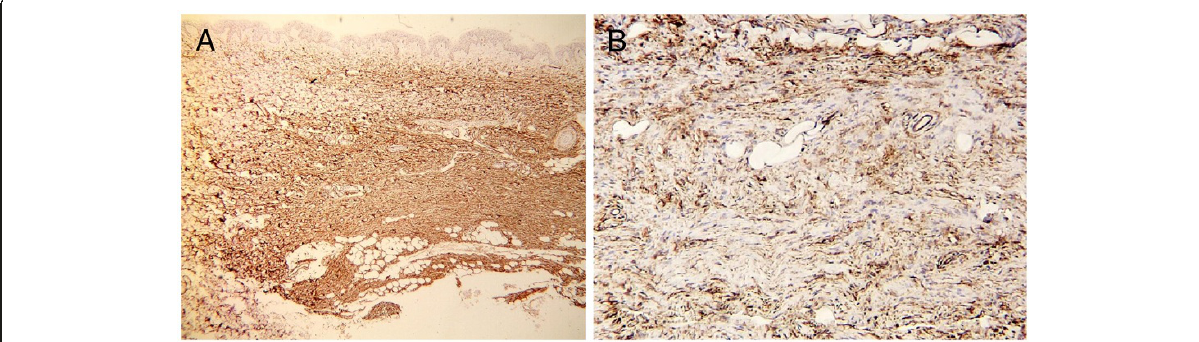
Figure 3 The spindle cells were immunohistochemically positive for CD34 (CD34 stain; original magnifications: A, ×40, B, ×